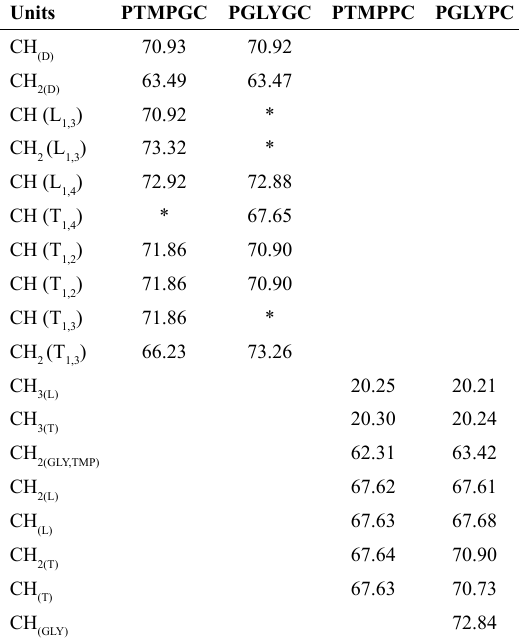
Table 1. NMR shifts of dendritic, linear, terminal units (CH and CH ) for PTMPGC, PGLYGC, PTMPPC and PGLYPC analyzed 2 by DEPT 135 and Inverse Gated